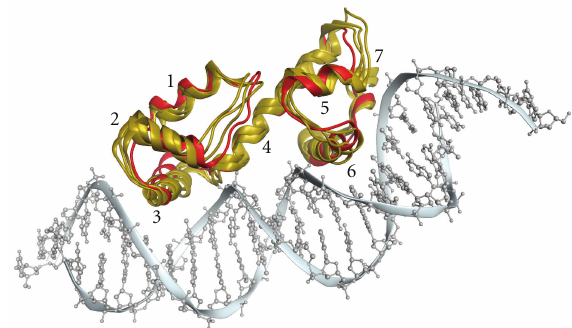
Figure 1: Structural alignment of three putative AraC/XylS family members (PDB codes: 3mn2, 3oio, and 3oou; gold ribbons) with MarA (PDB code: 1bl0; red ribbons). The DNA molecule of the MarA structure is shown for illustration (gray); however 3mn2, 3oio, and 3oou were crystallized without DNA. Numbers of α - helices are given next to the respective α -helix. The alignment was generated with SALIGN [16] and the figure was created with the Molecular Operating Environment (MOE)